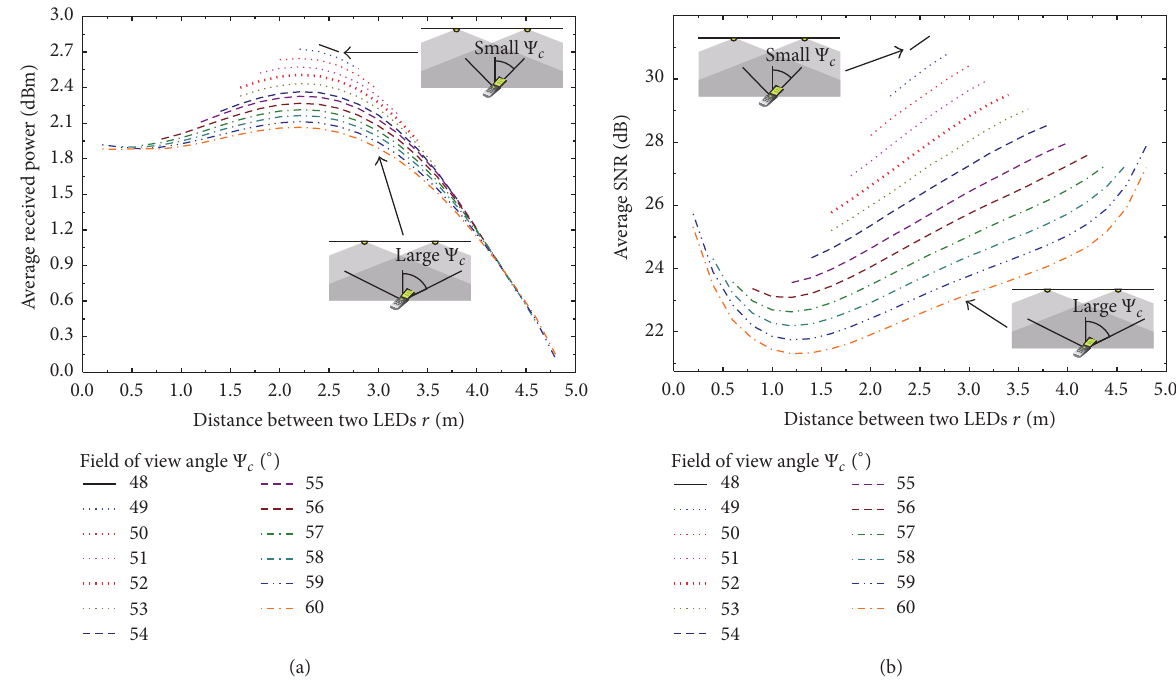
Figure 5: (a) Average received power and (b) average SNR level corresponding to the lighting layouts that give full-connectivity under different FOV